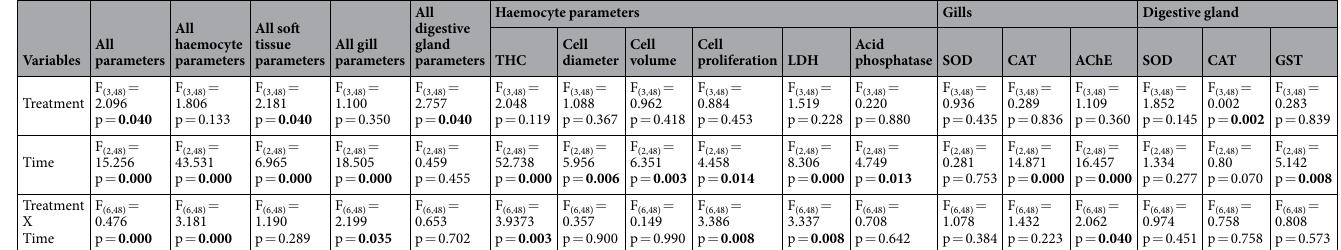
Table 1. PERMANOVA analysis results. Pseudo- F and p values are reported. Statistically significant effects of the variables “treatment”, “exposure time” and “treatment * time interaction” are indicated in